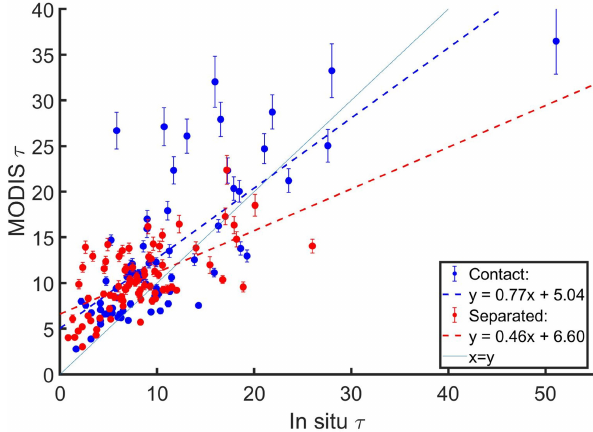
Figure 14. Same as Fig. 3a but with cloud profiles colored based on regime classification.